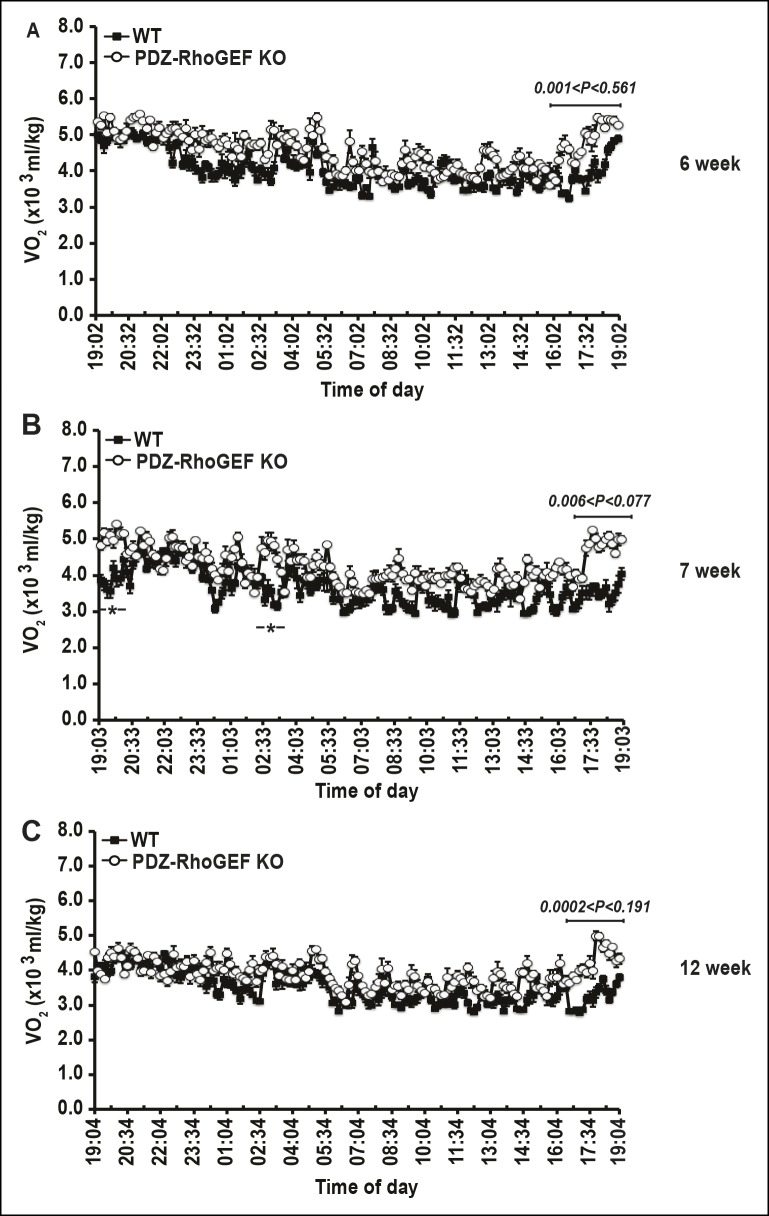
Energy homeostasis of male wild type and PDZ-RhoGEF KO mice at different ages.(A–C) The time course of oxygen consumption rate (VO2) measured during light and dark periods under normal food (n = 4).